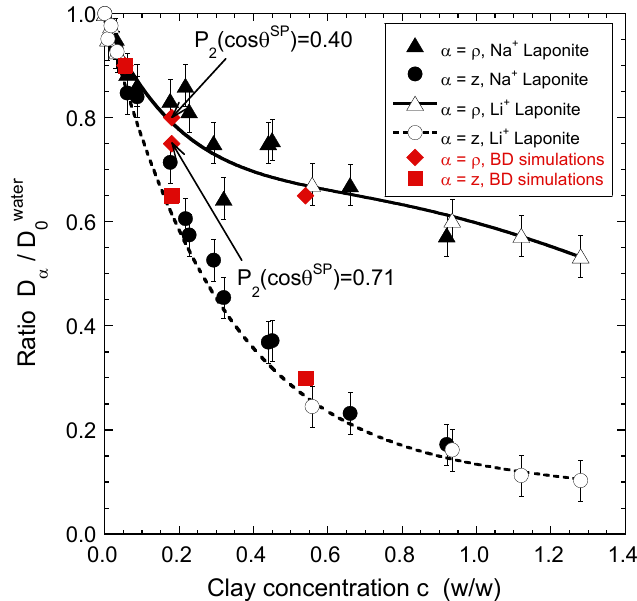
Figure 15. Influence of the clay concentration on the water self-diffusion tensor measured within laponite aqueous dispersion by using 1 H NMR Pulsed-Gradient Spin-Echo attenuation. Reprinted with permission from Ref. [50]. Copyright (2008) American Chemical